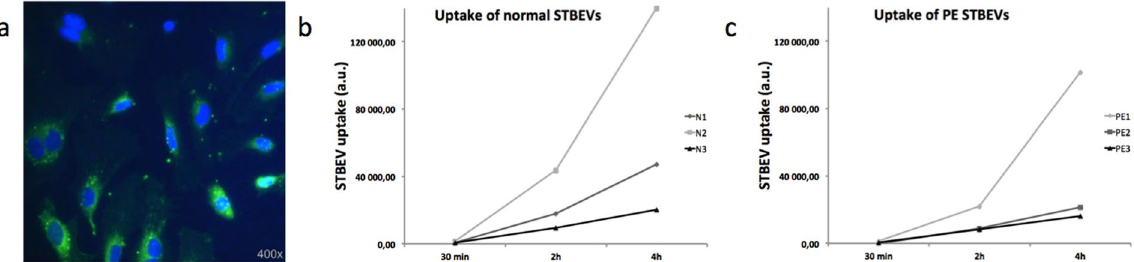
Figure 2. Time course assessment of STBEV uptake. HCAEC uptake of PKH-labelled STBEVs was visualised using fluorescent microscopy ( a ). A representative image of HCAECs following 6 hours of incubation with PKH-labelled STBEVs. The cell nuclei are labelled blue and PKH-labelled STBEVs are seen as green. Time- dependent uptake of normal (b, N1-N3) and PE (c, PE1-PE3) STBEVs was quantified using flow cytometry. Although variable between samples, all samples showed a time-dependent uptake. The horizontal axis shows mean fluorescent values; a.u., arbitrary units.